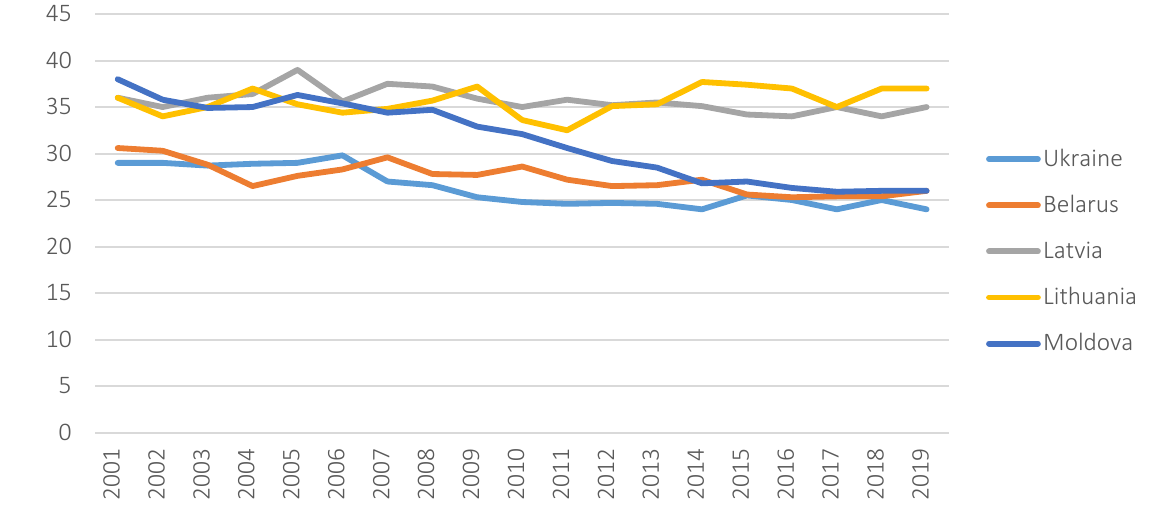
Figure 1. Gini index of the Eastern European countries for the period